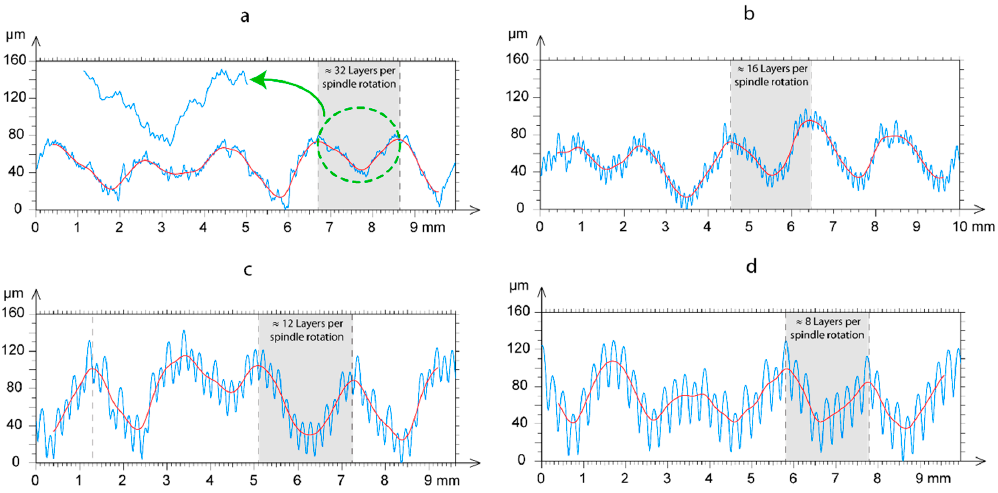
Figure 9. Detail of periodic waviness in an upright orientation: ( a ) Lt =0.06 mm, ( b ) Lt =0.12 mm, ( c ) Lt = 0.18 mm and ( d ) Lt = 0.24 mm. ( c ) Lt = 0.18 mm and ( d ) Lt = 0.24